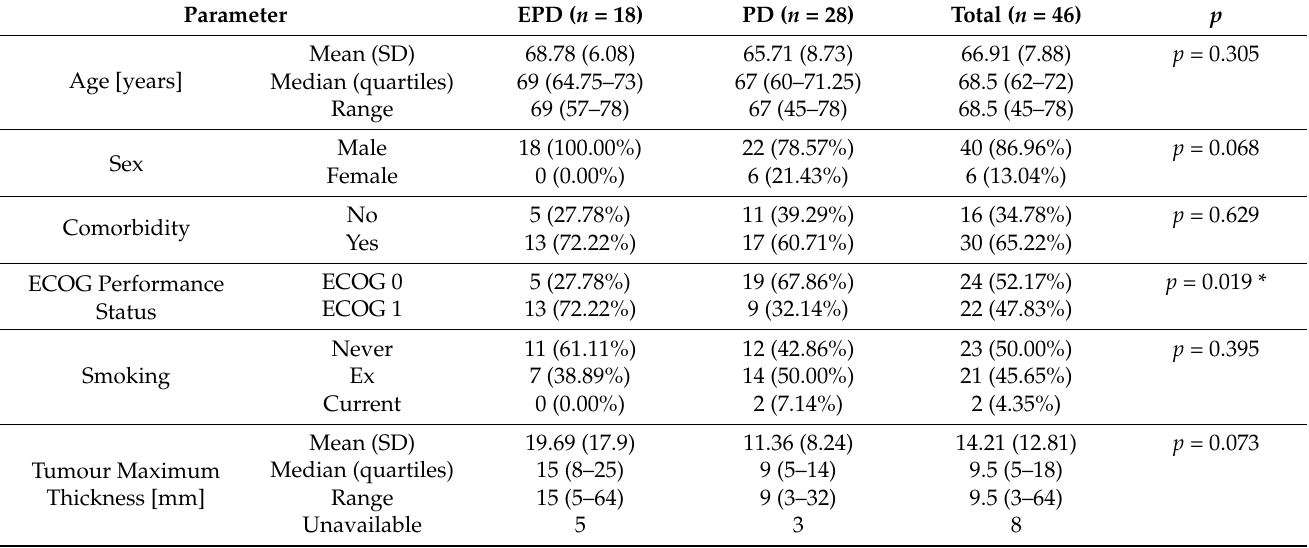
Table 1. Pre-Operative Patient Characteristics. EPD indicates extended pleurectomy/decortication; PD, pleurectomy/decortication; SD, standard deviation; ECOG, The Eastern Cooperative Oncol- ogy Group.